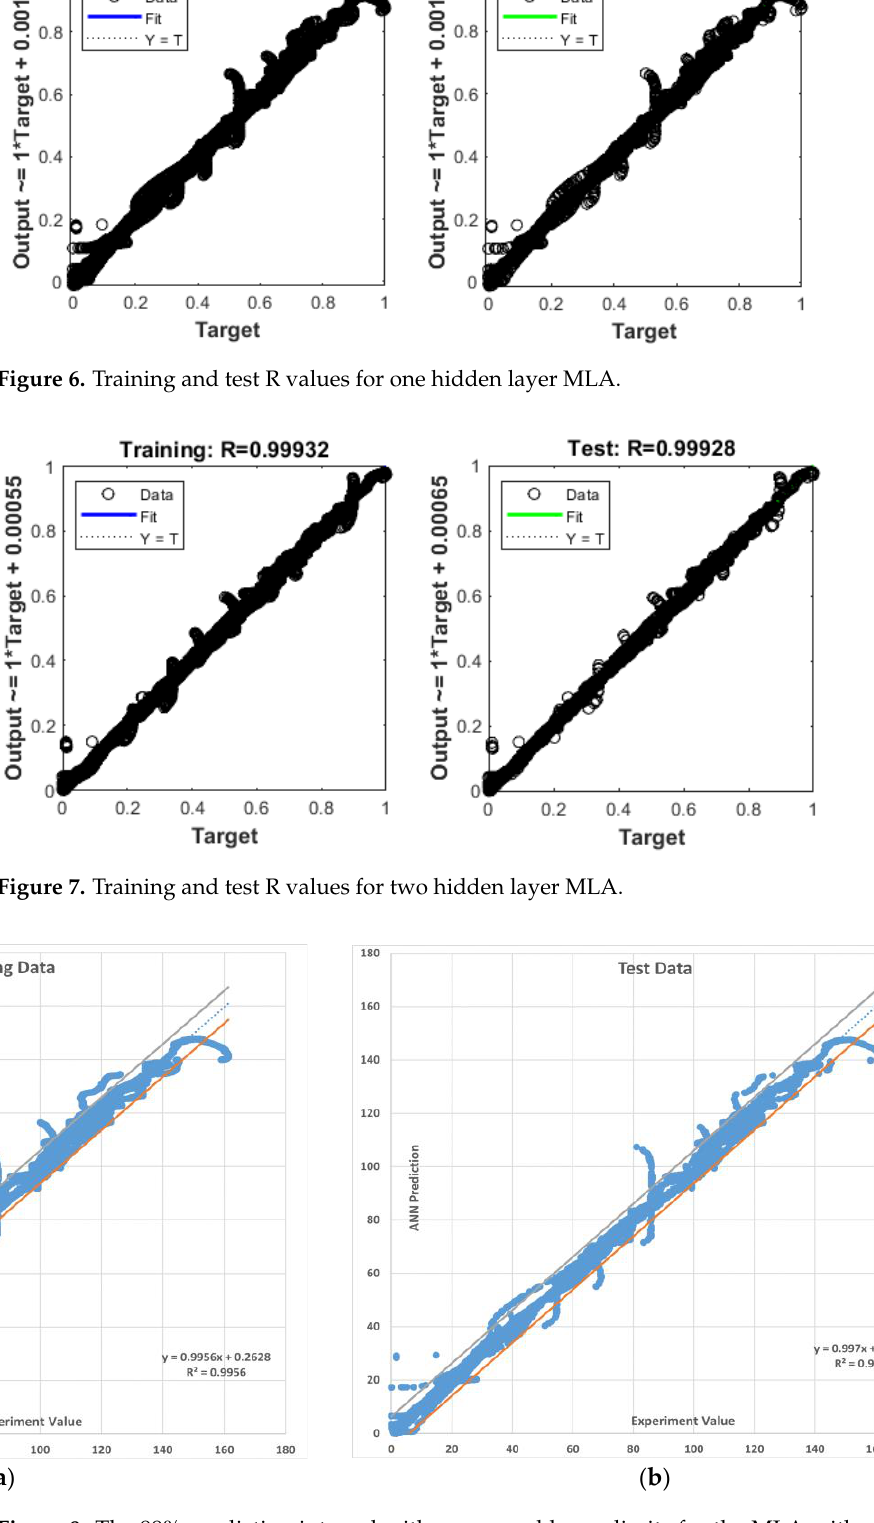
Figure 8. The 99% prediction interval with upper and lower limits for the MLA with one hidden layer. ( a ) Training data ( b ) Testing data